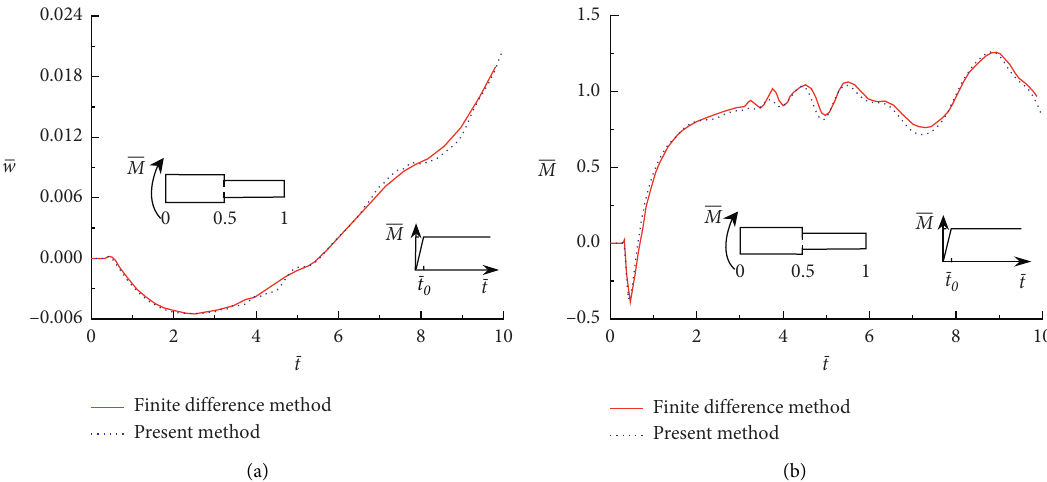
Figure 4: Time-history contrast curve at the x � 0 . 2 from the left end of the beam. (a) Time-history contrast curve of the transverse displacement w . (b) Time-history contrast curve of the bending moment.